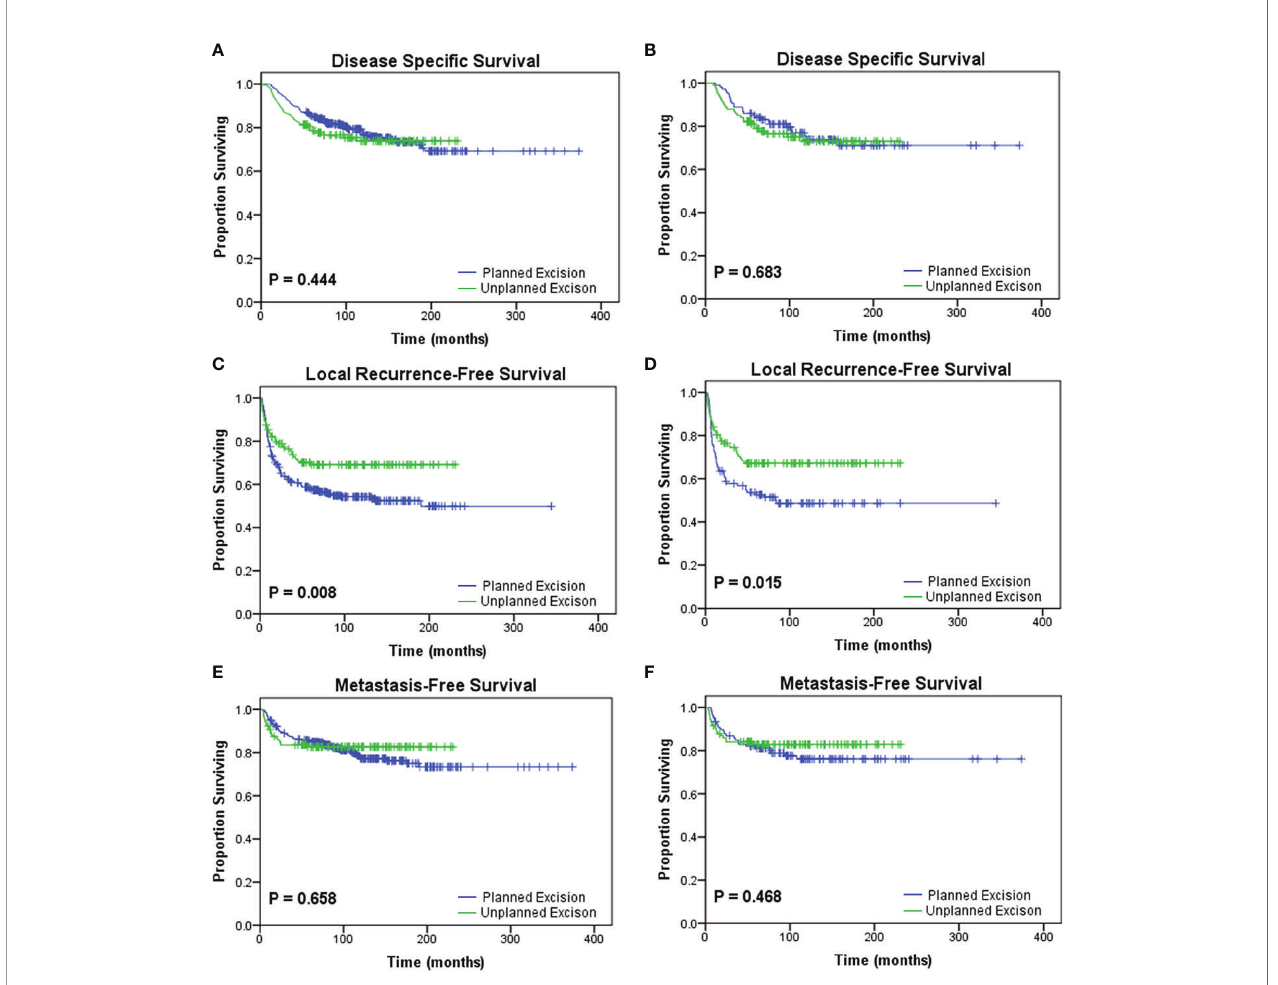
FIGURE 1 | Kaplan-Meier analyses of the oncologic outcomes of the planned excision group and unplanned excision group in the unmatched study cohort (A, C, E) and the matched study cohort (B, D, F) . Patients who underwent unplanned excision followed by R0 resection had similar (A, B) disease-speci fi c survival (p=0.444, p=0.683) and (E, F) metastasis-free survival (p=0.658, p=0.468) but improved (C, D) local recurrence-free survival (p=0.008, p=0.015) compared with those who underwent planned